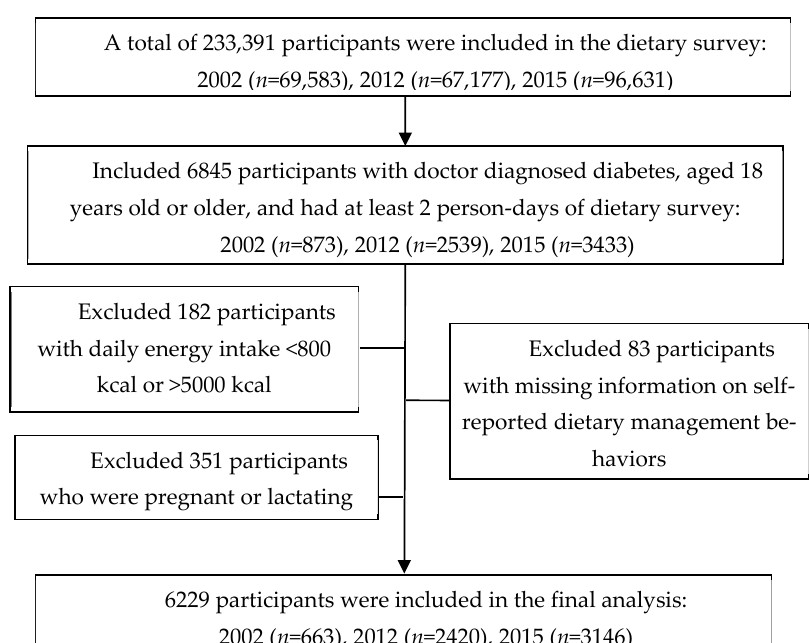
Figure 1. Flow of inclusion into the study.